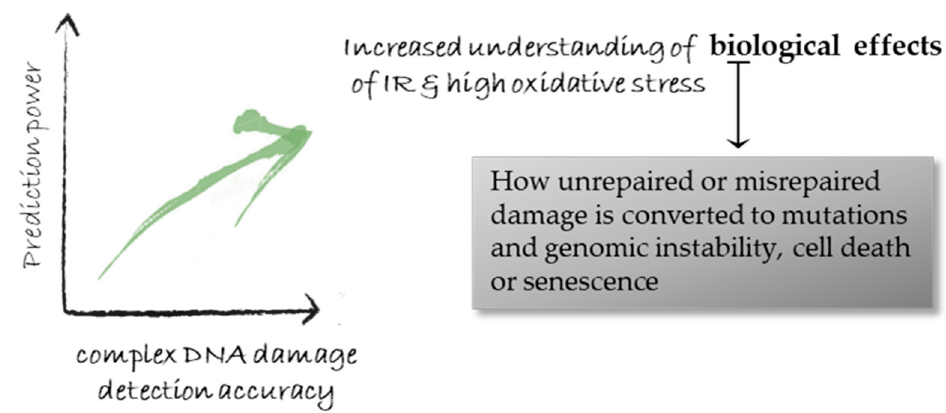
Figure 5. Improved and more accurate detection of complex (clustered) DNA damage leads to a more accurate understanding of the biological effects of IR and cancer (therapy and carcinogenesis), and provides predicting power for models and simulations of radiation-induced risks. The difficulty in improving detection accuracy is considered higher the inherent prediction power limitations.